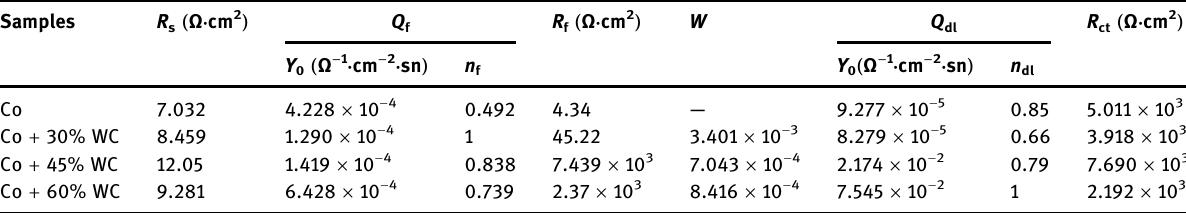
Table 5: Fitting parameters obtained by ZSimpWin from the EIS data for test samples Samples